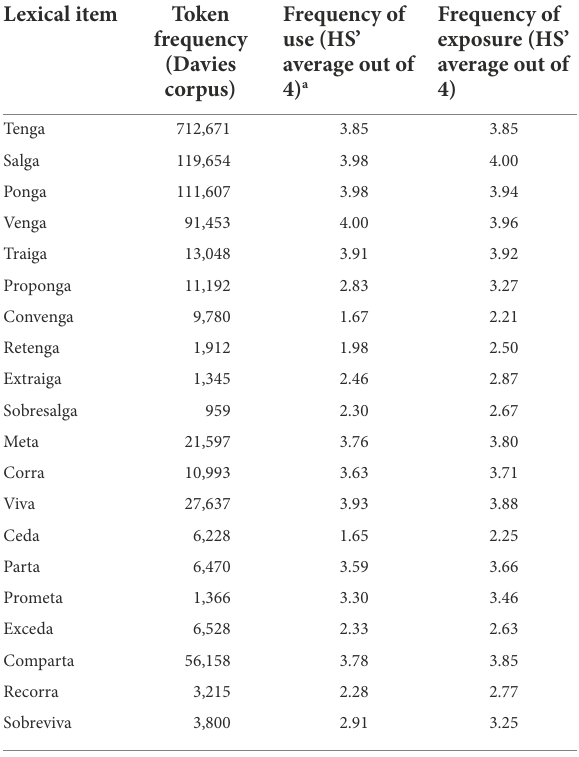
TABLE 4 Corpus-based and self-rated token frequency (exposure and use)